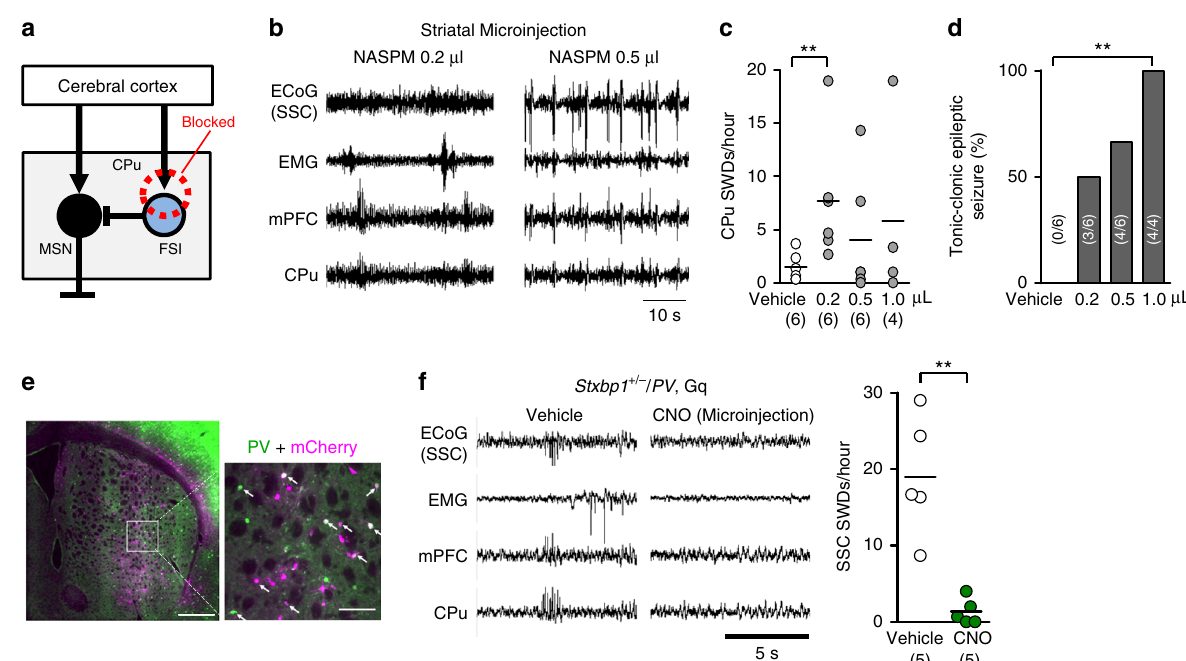
Fig. 6 Blockade of cortico-striatal FSI excitatory transmission causes SWDs and activation of FSI suppresses SWDs. a Local blockade of excitatory inputs to striatal FSIs by NASPM. b SSC-ECoG and LFP recordings at low (0.2 μ l) and high (0.5 μ l) doses of NASPM microinjection into the CPu of a WT mouse. SWDs in the mPFC and CPu (0.2 µ l) (left) and convulsive epileptic discharges in the SSC, mPFC, and CPu (0.5 µ l) (right). c Dose-dependent striatal SWDs in WT mice, caused by NASPM injections (3 h recording after injection). Vehicle ( N = 6) vs. low NASPM ( N = 6), Mann – Whitney U test, ** P = 0.0081. d Dose-dependent convulsive seizures caused by NASPM (3 h recording after injection). Mouse numbers are shown in parenthesis. Vehicle ( N = 6) vs. NASPM (1. 0 μ l, N = 4), Fisher ’ s exact test, ** P = 0.0048. e The majority of PV (green)-positive FSIs in the CPu expressed mCherry (magenta) after AAV injections, indicating expression of the DREADD receptors (arrows: double positive cells, including those with less dense PV signals). Coronal section, scale bars 500 µ m (left), 100 µ m (right). f SWDs were suppressed by CNO microinjection into the CPu of Stxbp1 + / − / PV Gq mice. Number of SWDs (right, 3 h recording). Stxbp1 + / − / PV Gq, vehicle vs. CNO, Mann – Whitney U test, ** P = 0.0079. Mean or Mean± SEM. ** P < 0.01